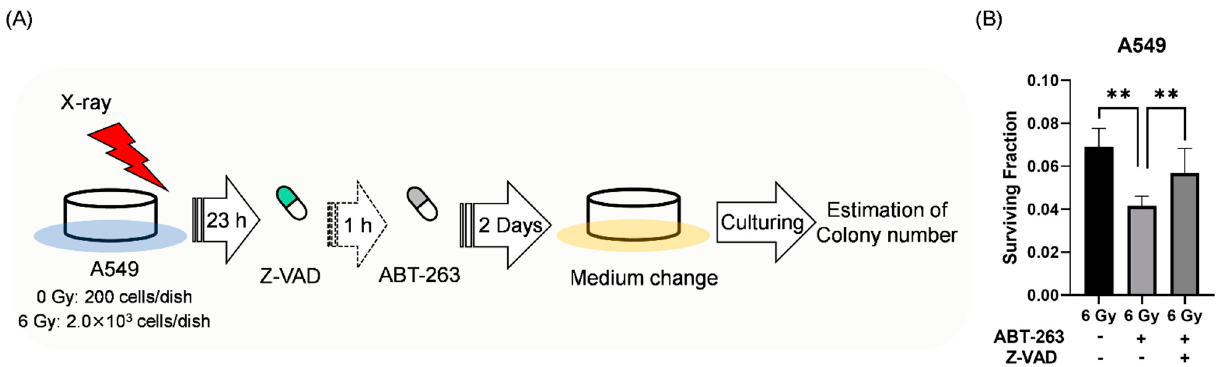
Figure 6. The caspase inhibitor Z-VAD attenuated the ABT-263-induced decrease in the surviving fraction of irradiated A549 cells. ( A ) The treatment procedure is shown. A549 cells irradiated at 6 Gy were cultured for 24 h prior to the addition of ABT-263 (5 μ M) to the culture. After two days of culture, the medium containing Z-VAD and ABT-263 was replaced with fresh medium. The cultures were continued until colonies were formed. Then, the colony number was counted. ( B ) The surviving fraction of A549 cells is shown. Data are presented as the mean ± SD of independent experiments. ** p < 0.01.